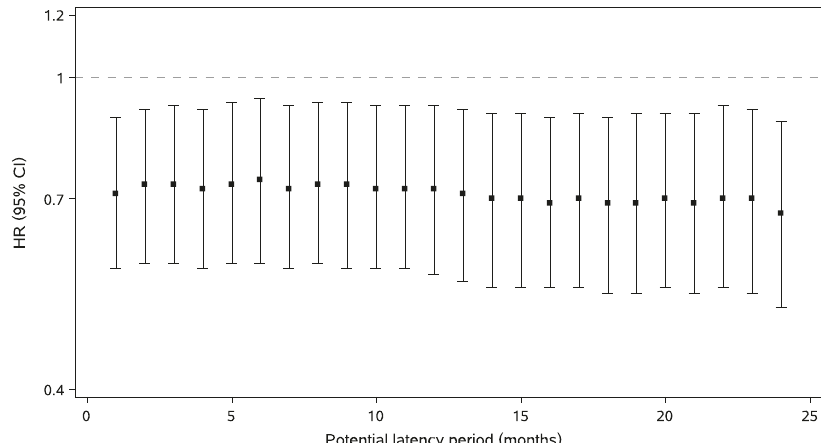
Fig. 3 Sensitivity analyses for different potential latency periods. The length of latency period increased by one month in each sensitivity